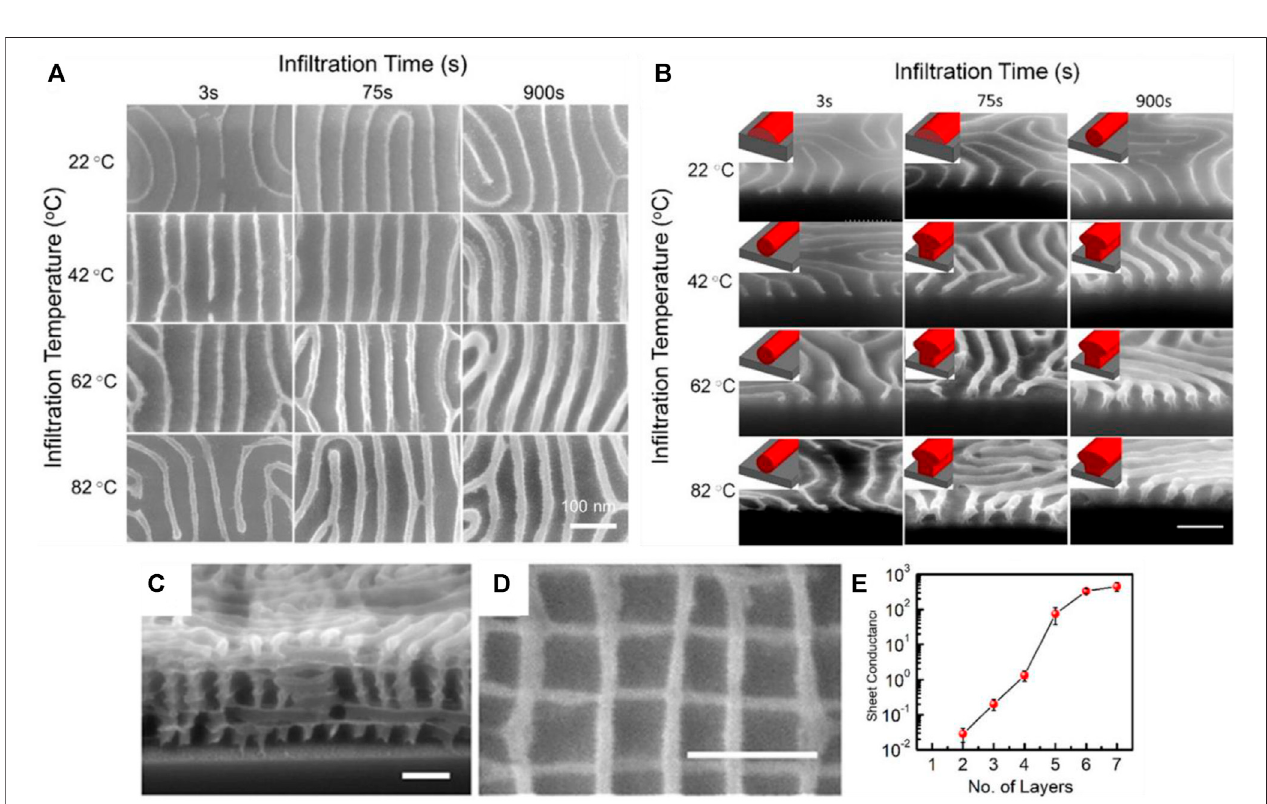
FIGURE8| EvolutionofPtnanowirelinewidth,height,andcross-sectionalshapeuponchangingin fi ltrationsoaktimeandtemperature (A) Top-viewand (B) cross- sectional SEM images with insets depicting schematic cross-sectional shapes; High-magni fi cation cross-sectional (C) and top-view (D) SEM micrograph images of a seven-layer Pt nanomesh; (E) Stack-layer-number-dependent electrical conductance of Pt nanoarchitectures. All scale bars denote 100 nm. Reproduced with permission from ref (Subramanian et al., 2020).